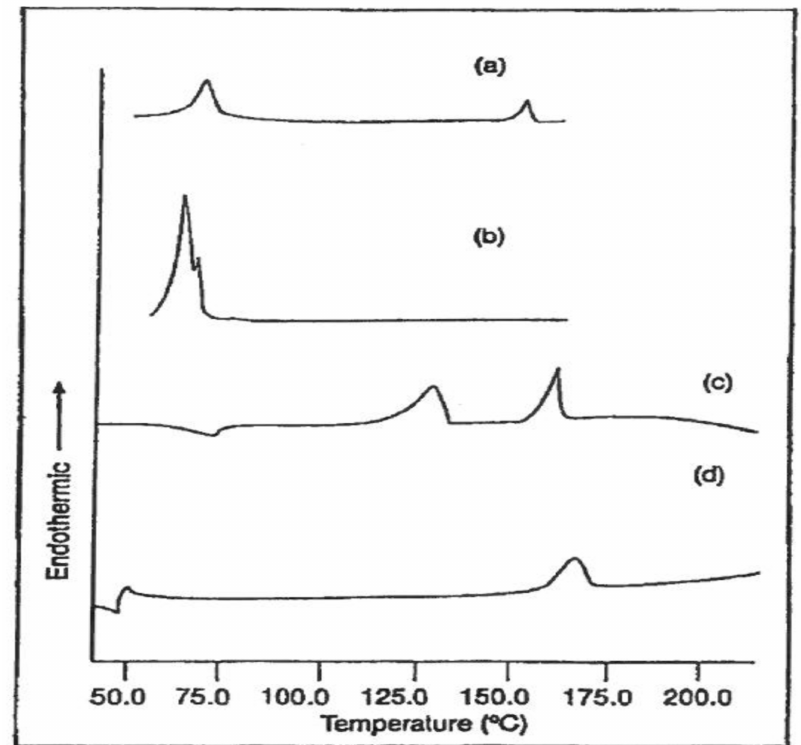
Figure 17. DSC scans of PCL embedded with PCL-U-IC before ( a ) and after ( b ) washing in methanol, and DSC scans of PLLA embedded with PCL-U-IC before ( c ) and after ( d ) washing in methanol obtained with permission from [47]. Copyright 2001